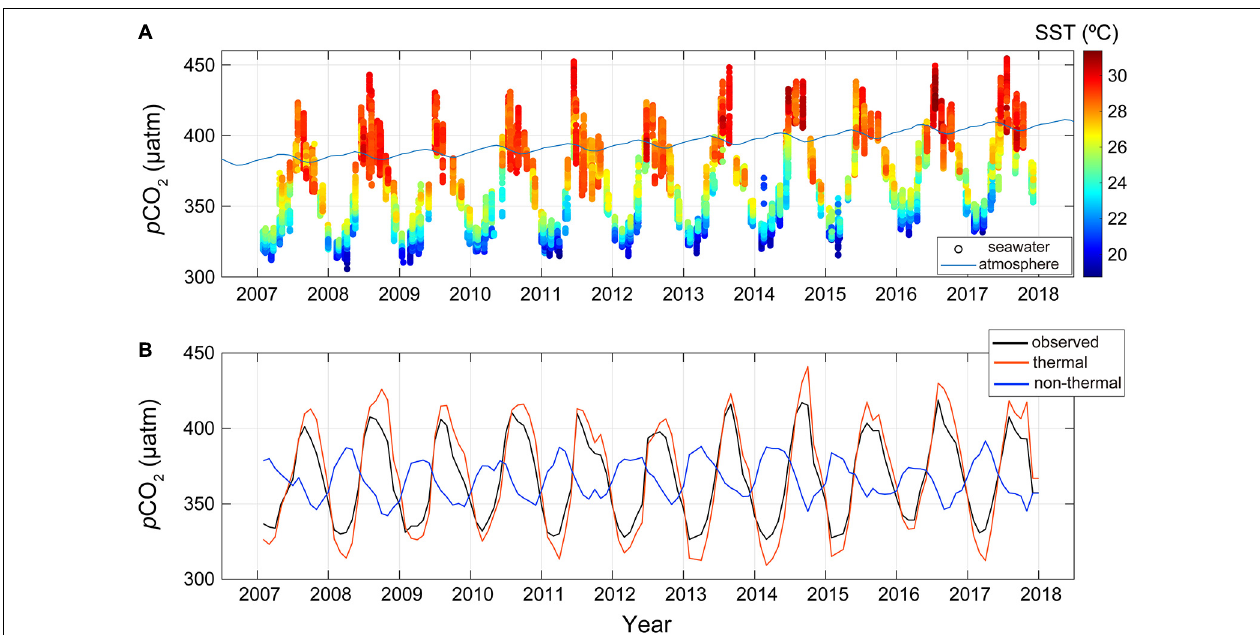
FIGURE 1 | Time series of (A) observed surface seawater CO 2 partial pressure ( p CO 2 obs ; µ atm) and (B) monthly p CO 2 ( µ atm) in the study region (22 ◦ N–28 ◦ N, 135 ◦ E–145 ◦ E) in the western Pacific Ocean. The p CO 2 obs values were obtained from the Surface Ocean CO 2 Atlas (SOCAT) database. The color bar indicates the measured sea-surface temperature (SST; ◦ C), and the solid line in (A) represents the atmospheric values of p CO 2 . Monthly p CO 2 values in (B) were normalized to a single reference year (2012) using the linear regression trend of 2.2 µ atm year − 1 . The solid red and blue lines in (B) represent the p CO 2 th and p CO 2 nt values,